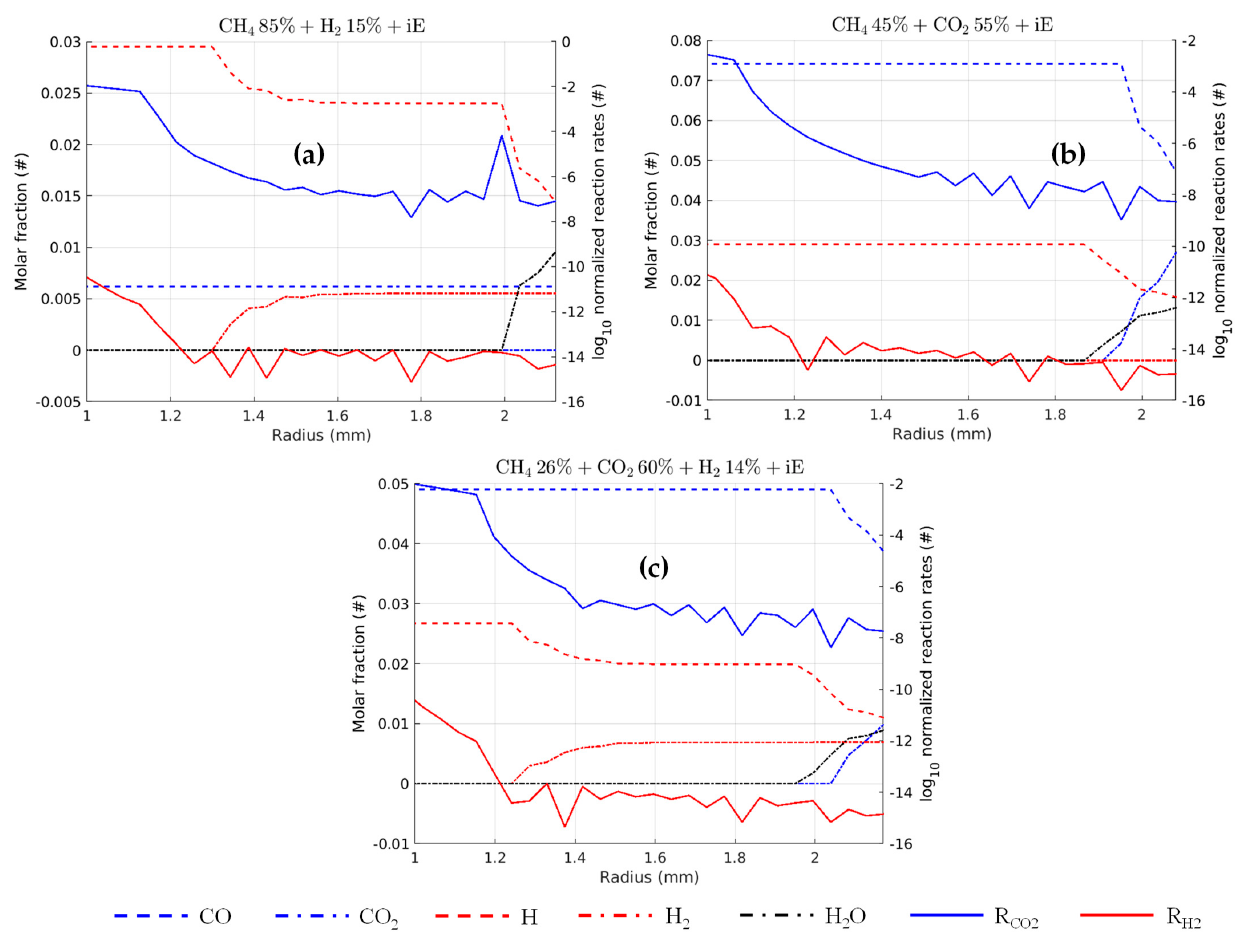
Figure 7. Radial penetration of H, CO radicals and H 2 , CO 2 , H 2 O molecules at the ignition time (left y-axis, dashed lines). The reaction rates of H 2 , CO 2 are also shown on the right y-axis (solid lines). Plot shown for three different fuel blends (methane–hydrogen 15% ( a ); biogas ( b ); biogas–hydrogen 14% ( c )).